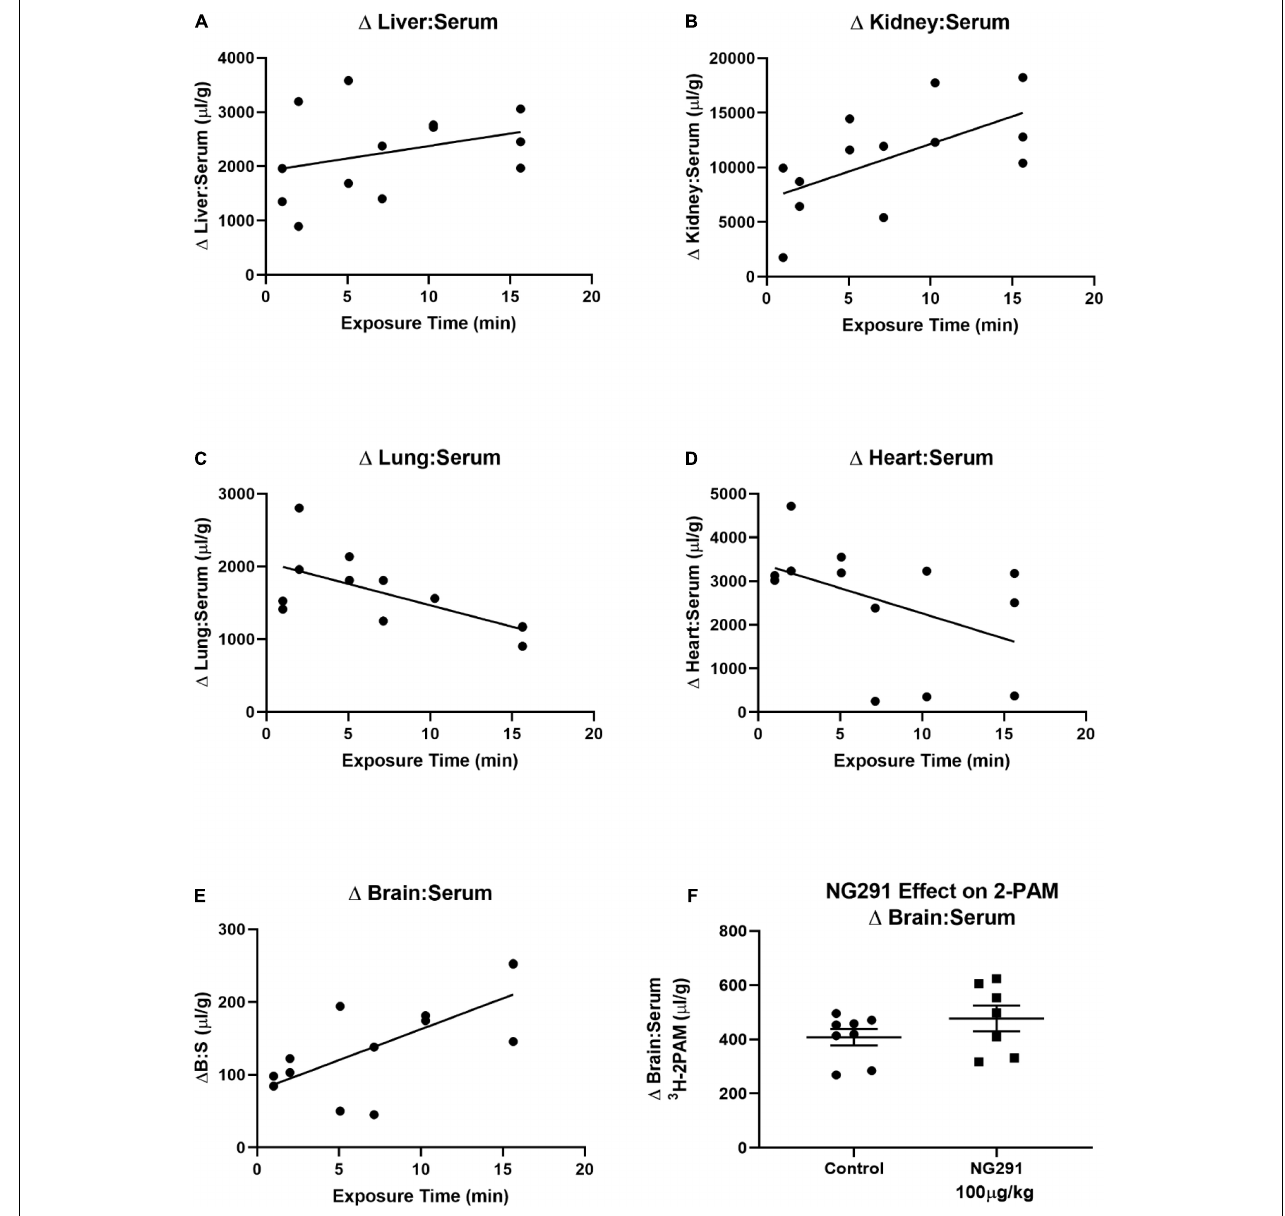
FIGURE 4 | Preliminary 2-PAM kinetics and the effect of NG291 on the 2-PAM brain to serum ratio. Preliminary 3 H-2-PAM kinetics was evaluated in tissue, and serum samples of mice were collected 1–15 min following 3 H-2-PAM injections (A–E) . In (F) , 100 µ g/kg of NG291 was administered along with 3 H-2-PAM and 99 m Tc-albumin and allowed to circulate for 15 min prior to harvesting brain and serum. Unpaired t -test reveals a p -value of 0.23 when comparing the 3 H-2-PAM brain to serum ratios between control and NG291 conditions (F) . In (F) , data is presented in terms of mean ±